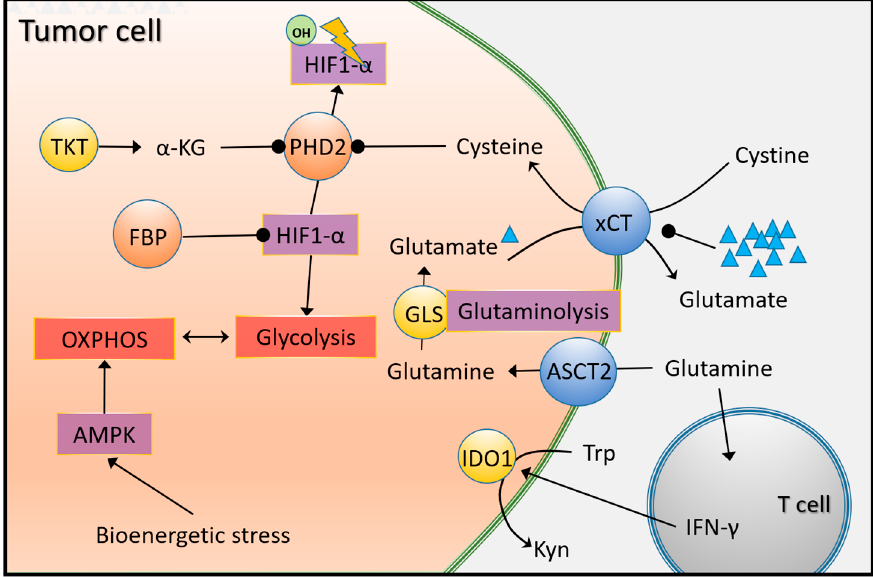
Figure 4. HIF-1 α -, glutamine-, and tryptophan-dependent metabolic reprogramming in TNBC. Under physiological conditions, PHD2 (prolyl hydroxylase domain 2) hydroxylates and degrades HIF-1 α (hypoxia inducible factor 1 subunit alpha) in an α -KG (alpha-ketoglutarate) and cysteine-dependent manner, thereby inhibiting aerobe glycolysis. In TNBC, PHD2 is inhibited by the cystine/glutamate antiporter xCT and TKT (transketolase), thereby upregulating enzymes and transporters involved in glycolysis. In addition to glycolysis, the entry of amino acids into the TCA cycle also leads to energy gains. In TNBC, the levels of the ASCT2 transporter (responsible for glutamine uptake) and the enzyme GLS, which converts it to glutamate, are upregulated. Meanwhile, catabolism of tryptophan (Trp) is facilitated by overexpressed IDO1. The resulting kynurenine (Kyn) is involved in impairing the immune response and facilitating oncogenic signaling through T cell-derived IFN- γ (interferon γ ).